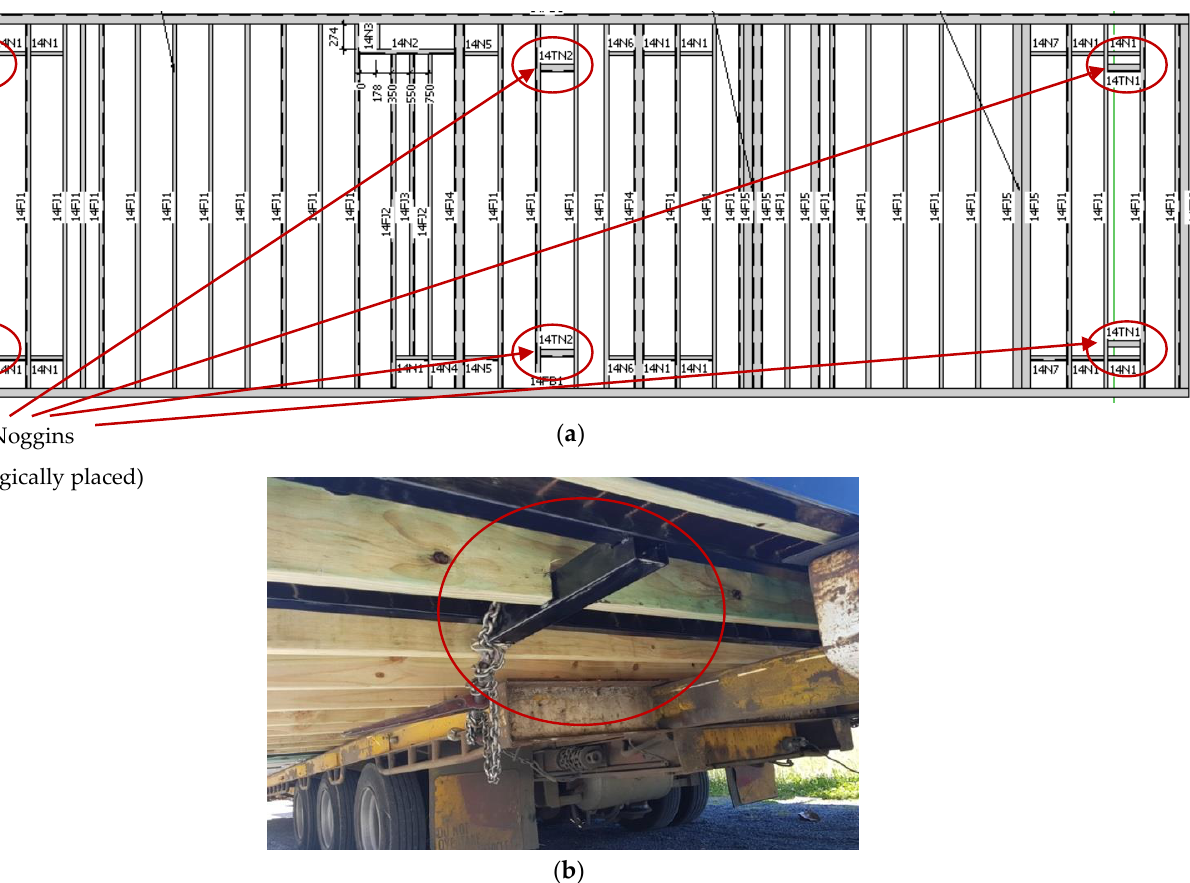
Figure 14. Detailing structural floor frames of volumetric modules to enable safe transportation where, ( a ) shows the placement of steel noggins on structural general arrangement drawings in between steel joists to provide elements to tie the module down to the trailer’s bed and ( b ) shows how the module is tied down to the trailer’s bed in reality.